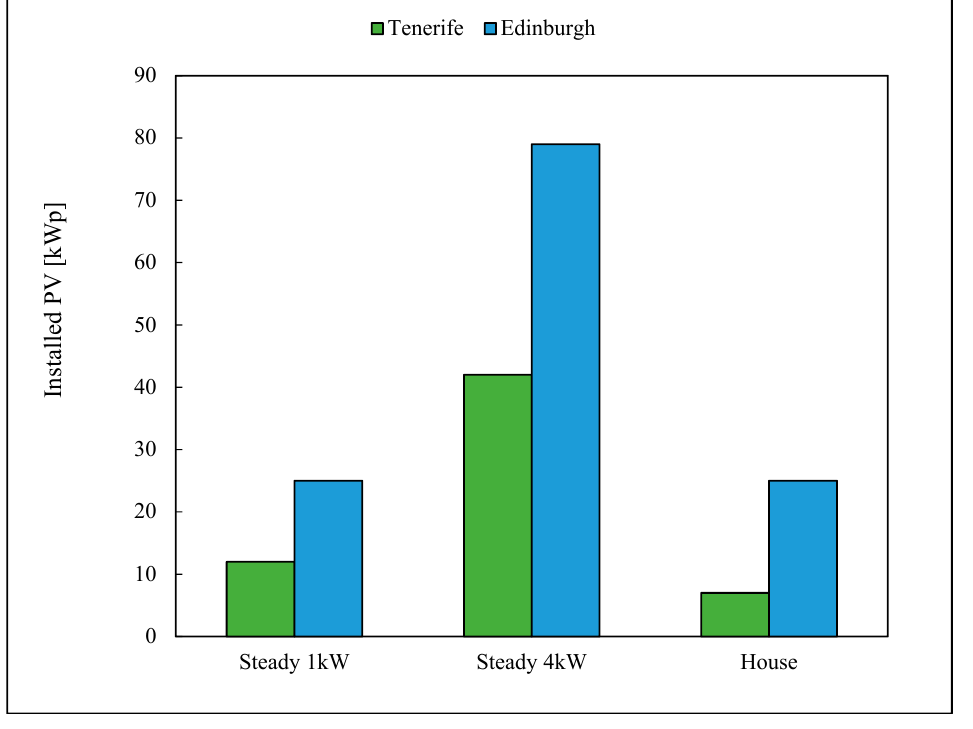
Figure 4. Minimum PV required based on lead-acid batteries.